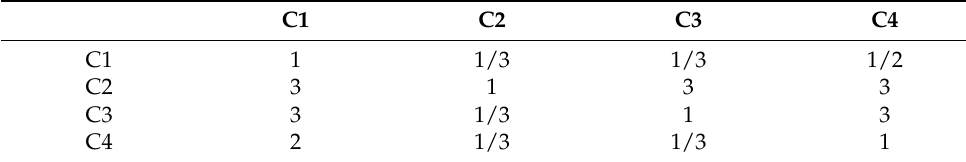
Table 1. Preference matrix